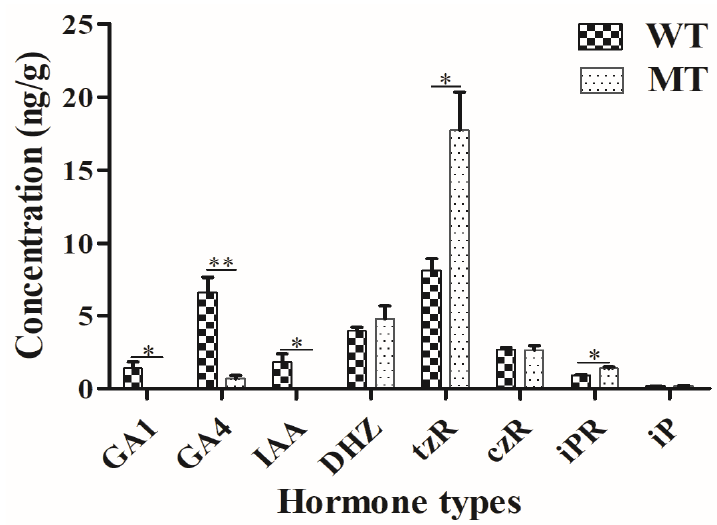
Figure2. ComparisonofhormonescontentbetweenWTandMTsamples. Thenumbersofconcentration Figure 2. Comparison of hormones content between WT and MT samples. The numbers of are mean values with their respective standard deviation. Significant di ff erences were marked with up concentration are mean values with their respective standard deviation. Significant differences were to asterisks. * ( p < 0.05), ** ( p < marked with up to asterisks. * ( p < 0.05), ** ( p < 0.01).